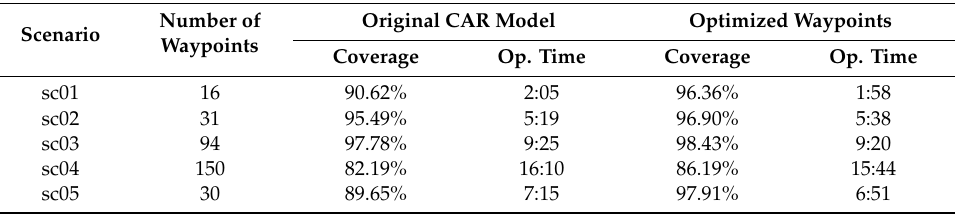
Table 3. Comparison of the original Cooperative Aerial Reconnaissance (CAR) model with optimized